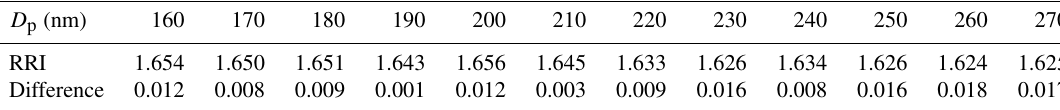
Table 1. The retrieved RRI and the absolute difference between the retrieved RRI and the theoretical RRI for different ammonia chloride diameters.